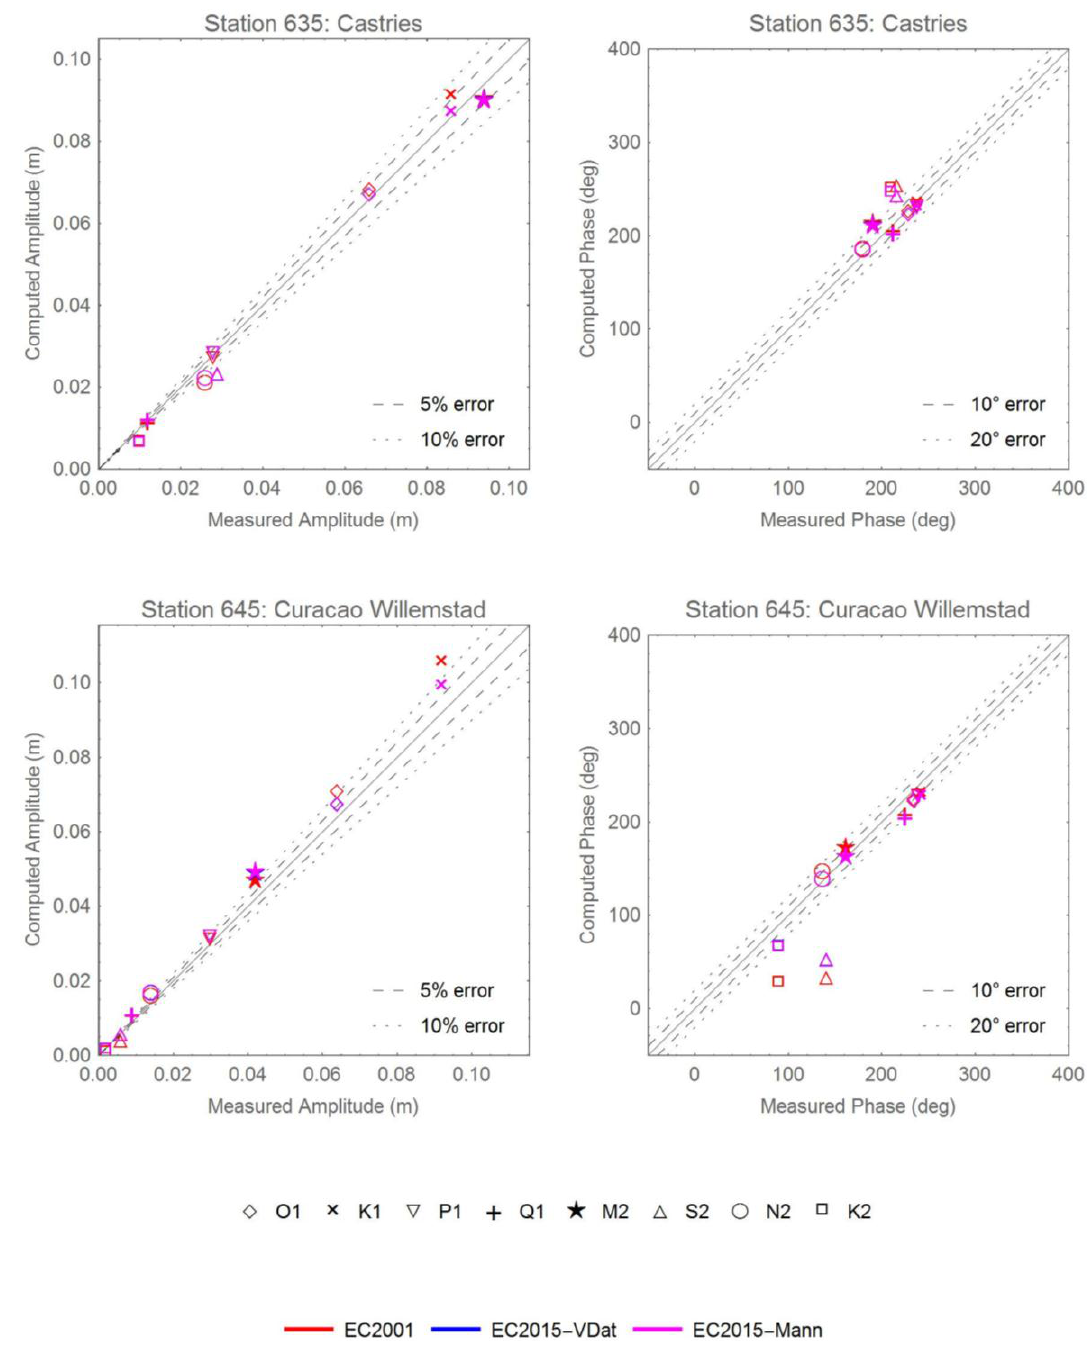
Figure B4. Scatterplots of computed versus measured harmonic data for representative stations in the Caribbean Sea.